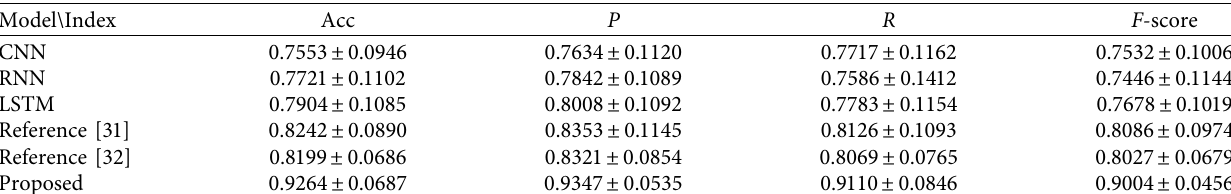
Figure 7: Experimental results of each model on different indexes in 3-classification task. Table 6: 4-classification experimental